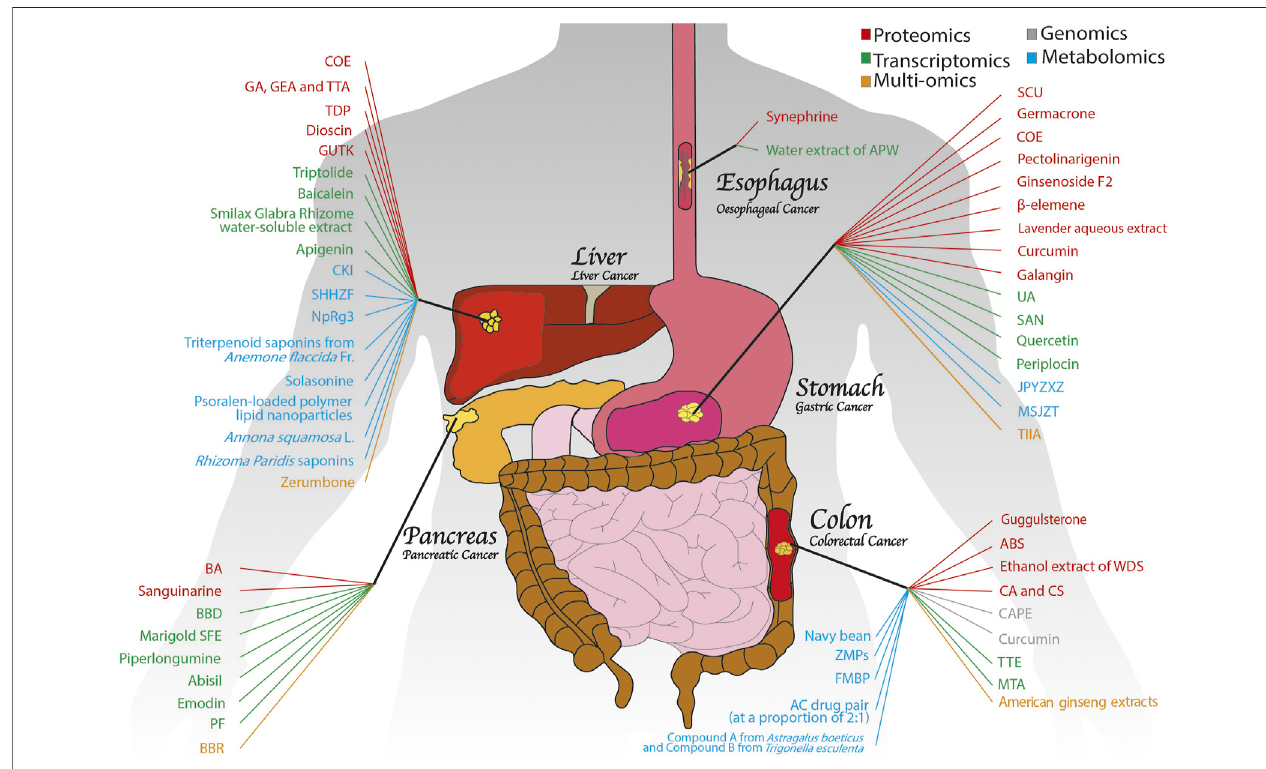
FIGURE2| Anoverviewofmedicinalplantswithanti-GIcancerpropertiesbasedonOMICS.Numerousmedicinalplantshaveexhibitedpotentantitumouractivities in GI cancers, including colon, pancreatic, gastric, liver and oesophageal cancers. With the help of different OMICS approaches, such as proteomics, genomics, transcriptomics, metabolomics and multi-OMICS, the anti-GI cancer mechanisms of medicinal plants have been explored extensively.